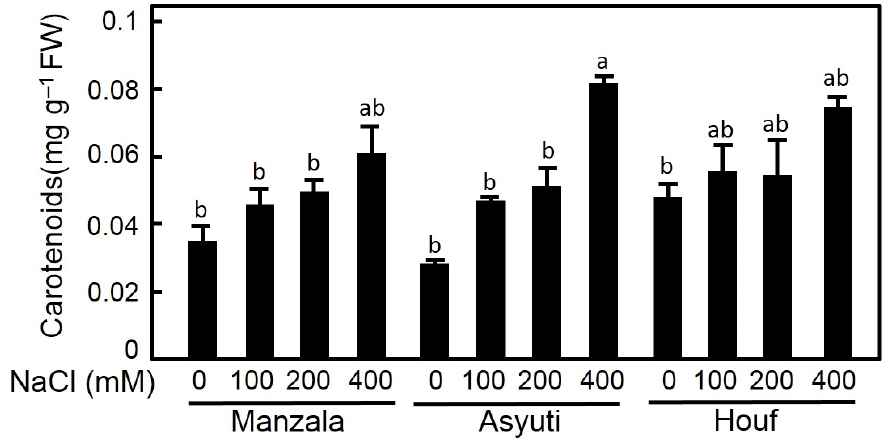
Figure 10. Effects of 45 days salt treatments (0, 100, 200 and 400 mM NaCl) on carotenoids in Z. coccineum from Manzala, Wadi Asyuti and Wadi Houf. Value represents the mean of 3 replicates ± standard error, p -value < 0.05. For variables denoted with the same letter, the difference is not statistically significant.